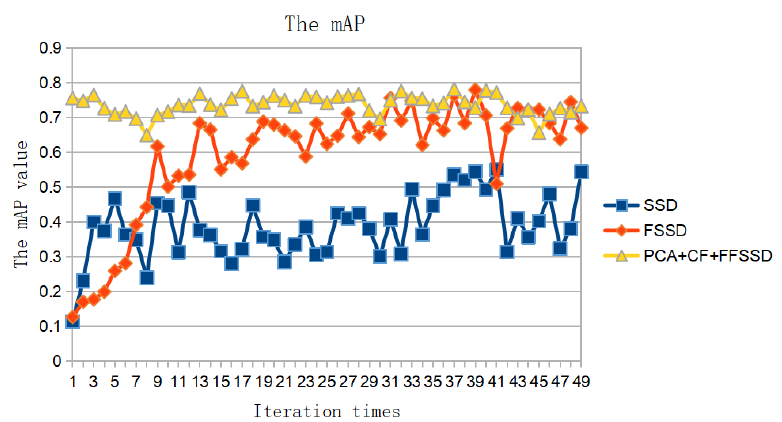
Figure 9. The mAP curve transformation during SSD, FSSD, and PCA+FFSSD training (a total of 5000 training